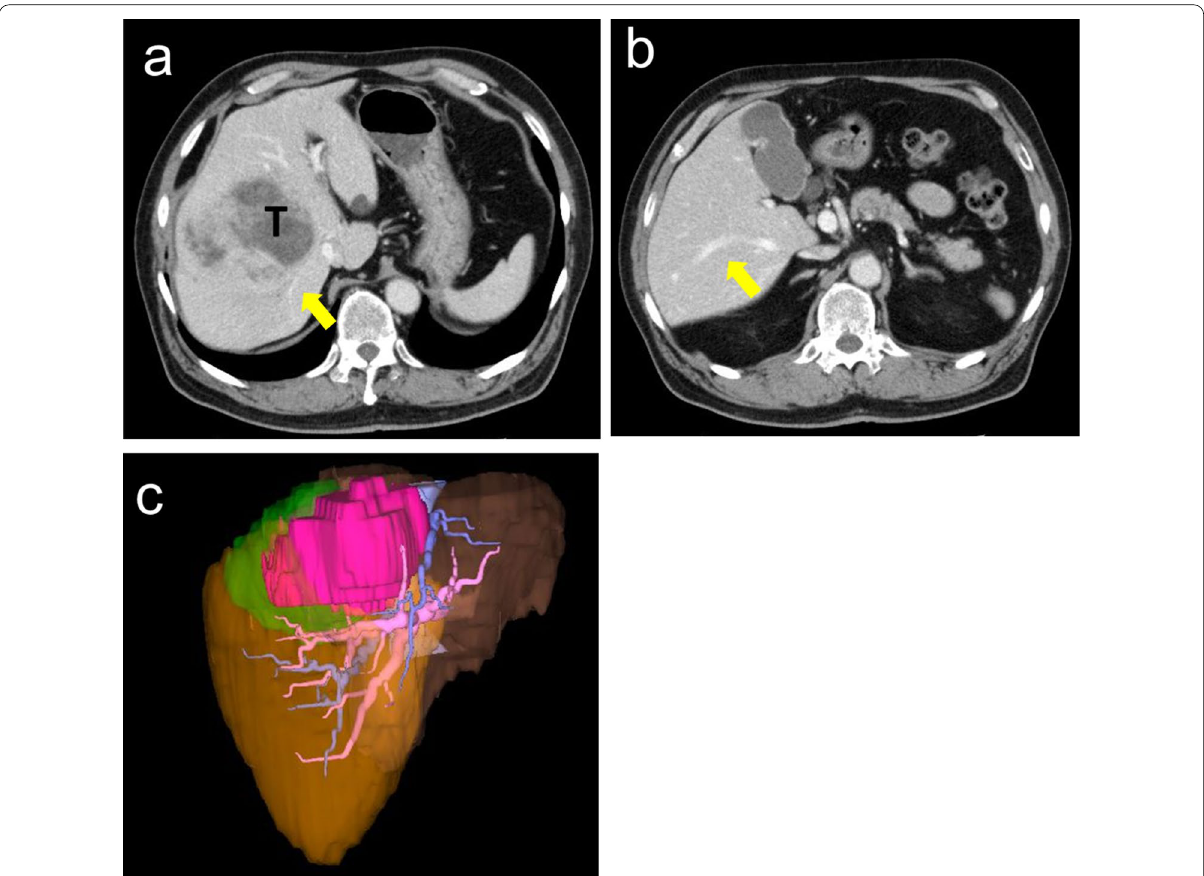
Fig. 1 Hepatocellular carcinoma occupying segments 7 and 8 involved the RHV. a Computed tomography showed the tumor located in segments 7 and 8. The tumor involved the RHV (yellow allow). b The thick IRHV (yellow arrow) was observed. c 3D CT imaging of the RHV (green), IRHV (orange) drainage areas, and tumor (pink). RHV; right hepatic vein. IRHV; inferior right hepatic vein. 3D CT, three-dimensional computed